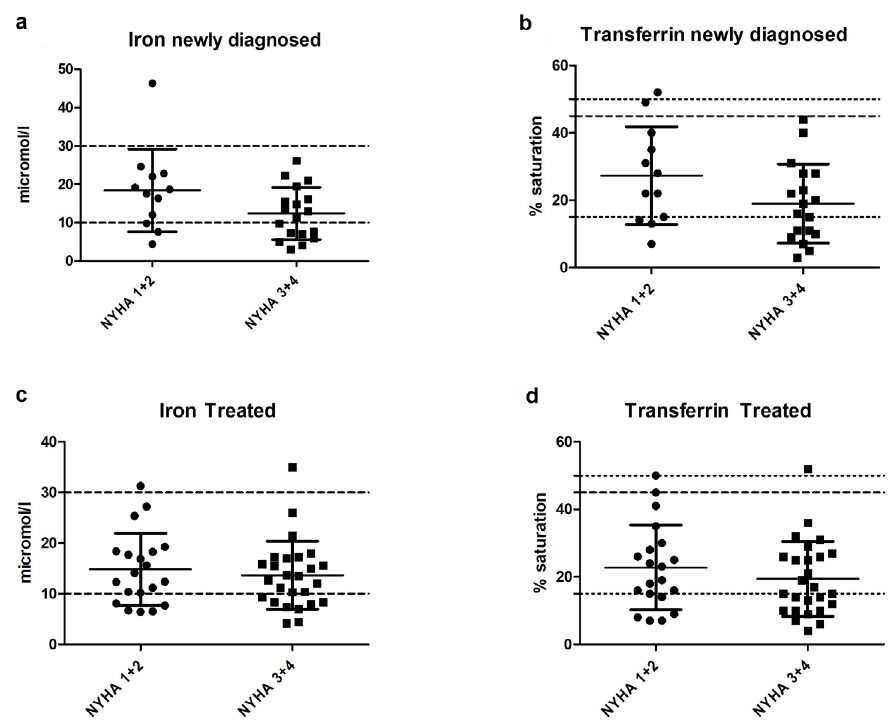
Figure 2. Iron levels and transferrin saturation in newly diagnosed and treated patients with NYHA classes 1 and 2 versus NYHA classes 3 and 4. ( a ) Iron levels in newly diagnosed PAH and CTEPH patients with NYHA classes 1 and 2 vs. NYHA classes 3 and 4. ( b ) Transferrin saturation levels in newly diagnosed PAH and CTEPH patients with NYHA classes 1 and 2 vs. NYHA classes 3 and 4. ( c ) Iron levels in treated PAH and CTEPH patients with NYHA classes 1 and 2 vs. NYHA classes 3 and 4. ( d ) Transferrin saturation levels in treated PAH and CTEPH patients with NYHA classes 1 and 2 vs. NYHA classes 3 and 4. NYHA: New York Heart Association.